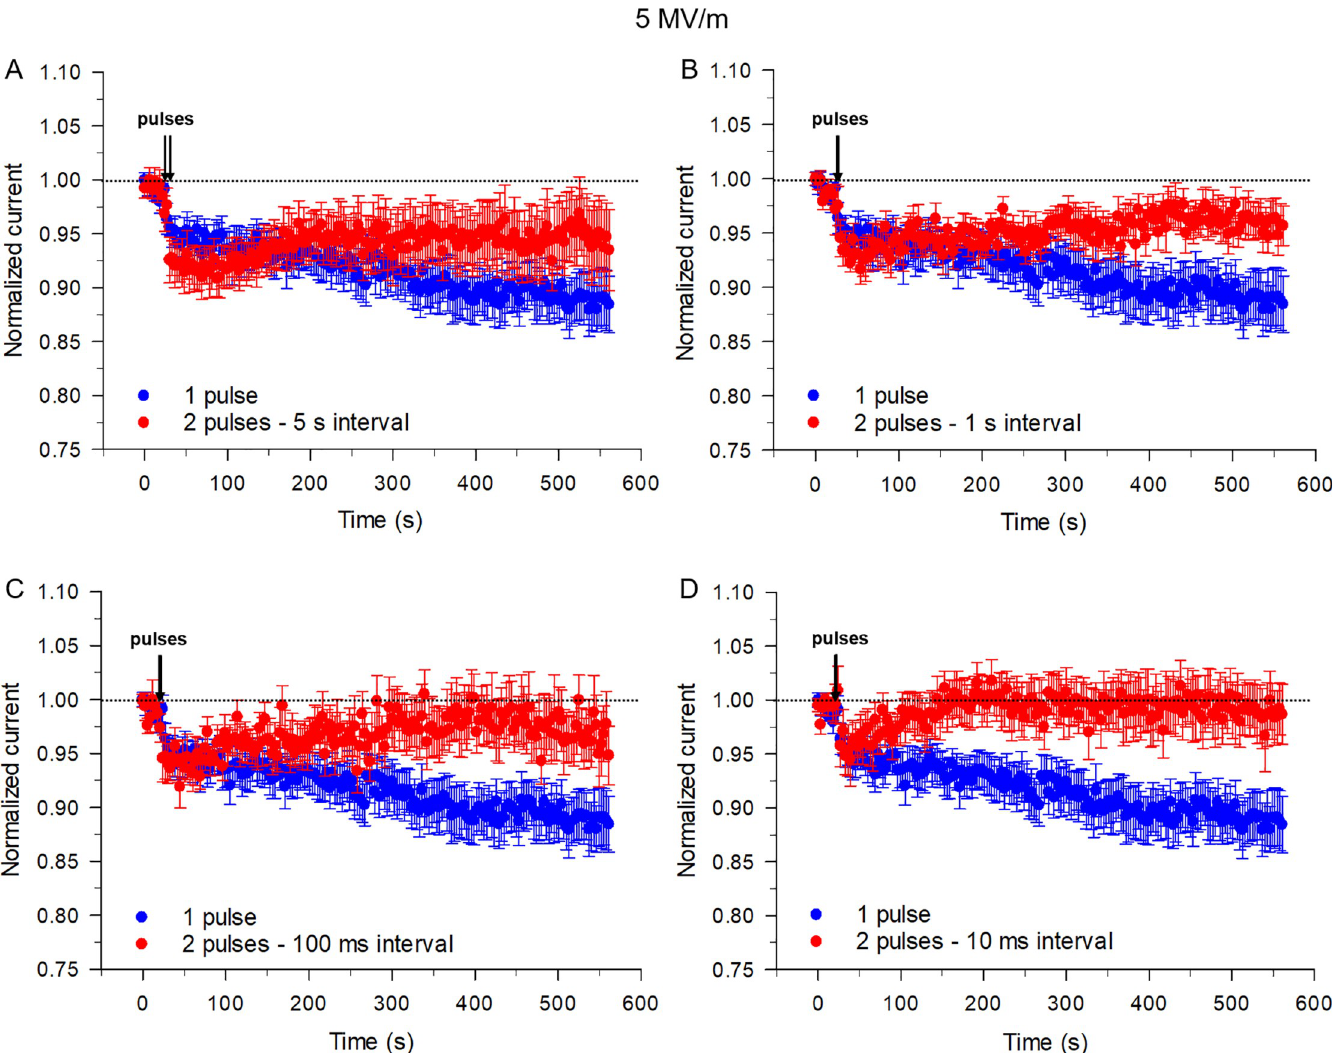
Fig 3. Effects on I Na of the time interval between twin NEPs applied at an E-field of 5 MV/m. Time course of changes in I Na for cells exposed to a single pulse (blue circles, data reproduced from Fig 2A) compared to cells exposed to twin NEPs (red circles) separated by a 5 s (A), 1 s (B), 100 ms (C) or 10 ms time interval (D), respectively. Each data point is a mean ± SE (1 pulse, n = 12; 2 pulses with a 5 s interval, n = 9; 2 pulses with a 1 s interval, n = 9; 2 pulses with a 100 ms interval, n = 9; 2 pulses with a 10 ms interval, n = 9).